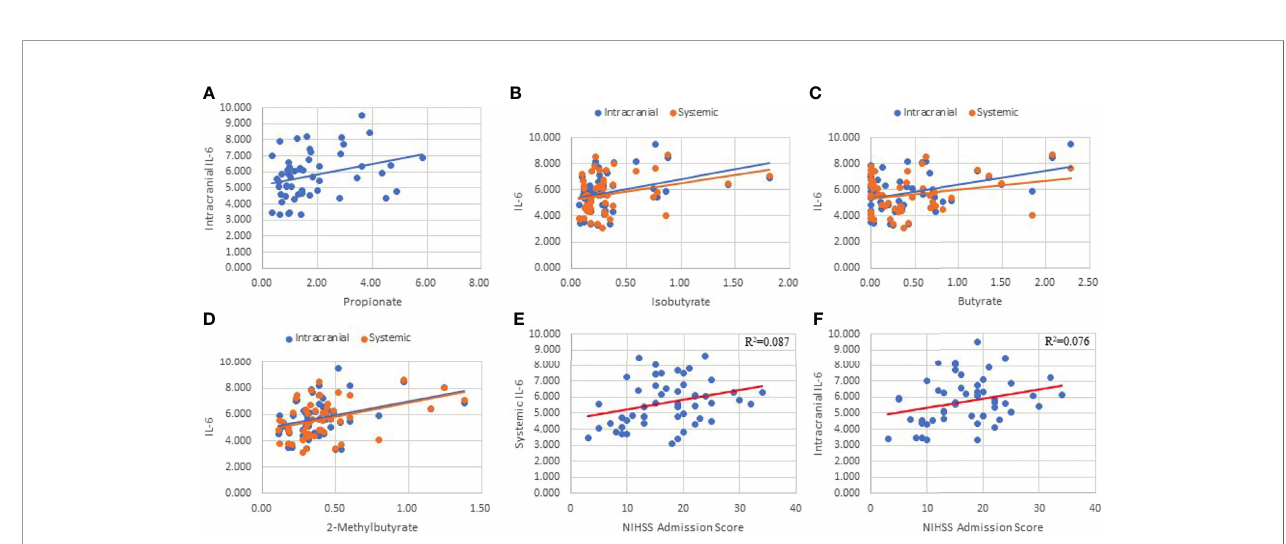
FIGURE 5 | Linear Regressions of IL-6 with SCFAs and NIHSS admission score. Intracranial IL-6 was correlated with Propionate (A) , Isobutyrate (B) , Butyrate (C) , 2-Methylbutyrate (D) , and NIHSS Admission (F) . Systemic IL-6 was correlated with Isobutyrate (B) , Butyrate (C) , 2-Methylbutyrate (D) , and NIHSS Admission (E)